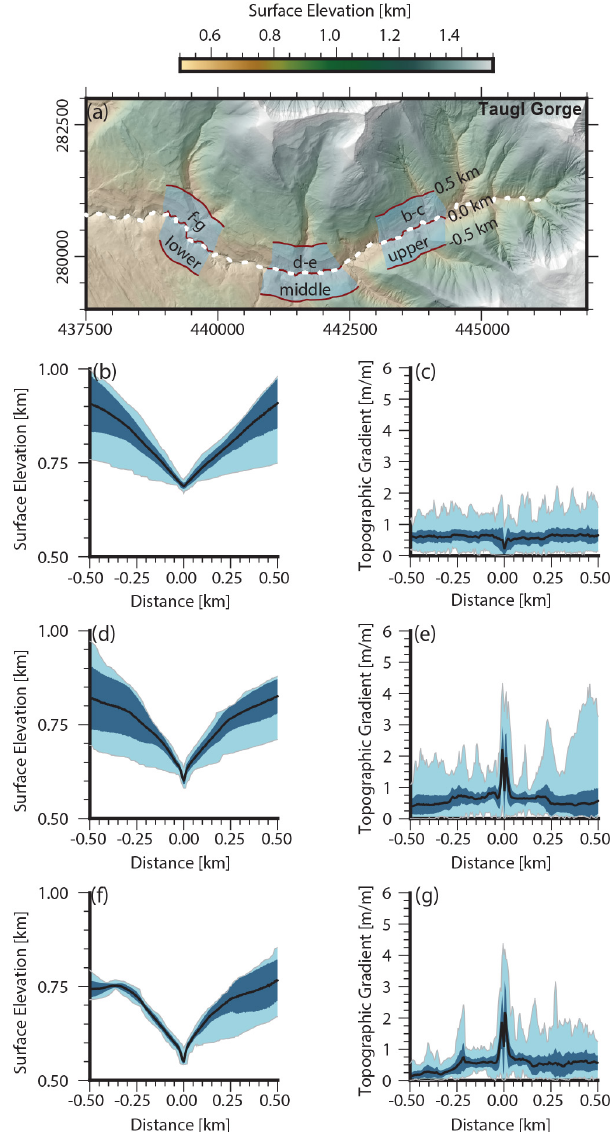
Figure 4. (a) Average geomorphic parameters of three morpholog- ically di ff erent sections of the Taugl Gorge (Austria). The baseline (white and red dashed line) follows the course of the Taugl River. The blue transparent regions cover all values included in the pro- files as annotated. Topography (b, d, f) and topographic gradient (c, e, g) are shown, comprising mean values (black line), extreme values (hull of the light blue area) and mean values ± 1 standard de- viation (hull of the dark area). The bin width of all profiles is 5m. Maps and profiles were derived from lidar based DEM data (spatial resolution 1m) in the MGI Austria M31 coordinate system provided by the federal government of